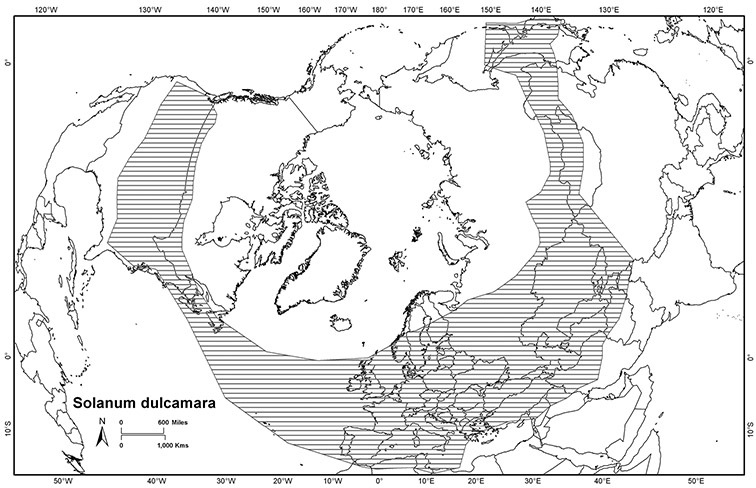
Distribution of Solanum dulcamara L.